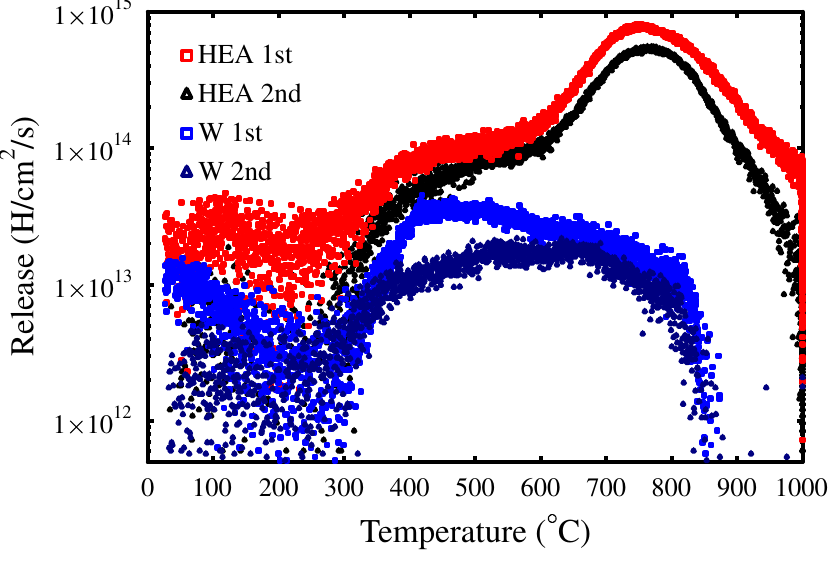
Figure 4. Hydrogen release signals from WMoTaNbV and W during the TDS measurements. The sec- ond measurement was taken after the samples had spent several weeks in the NTP conditions. Both materials reabsorb hydrogen from the atmosphere, WMoTaNbV significantly more than